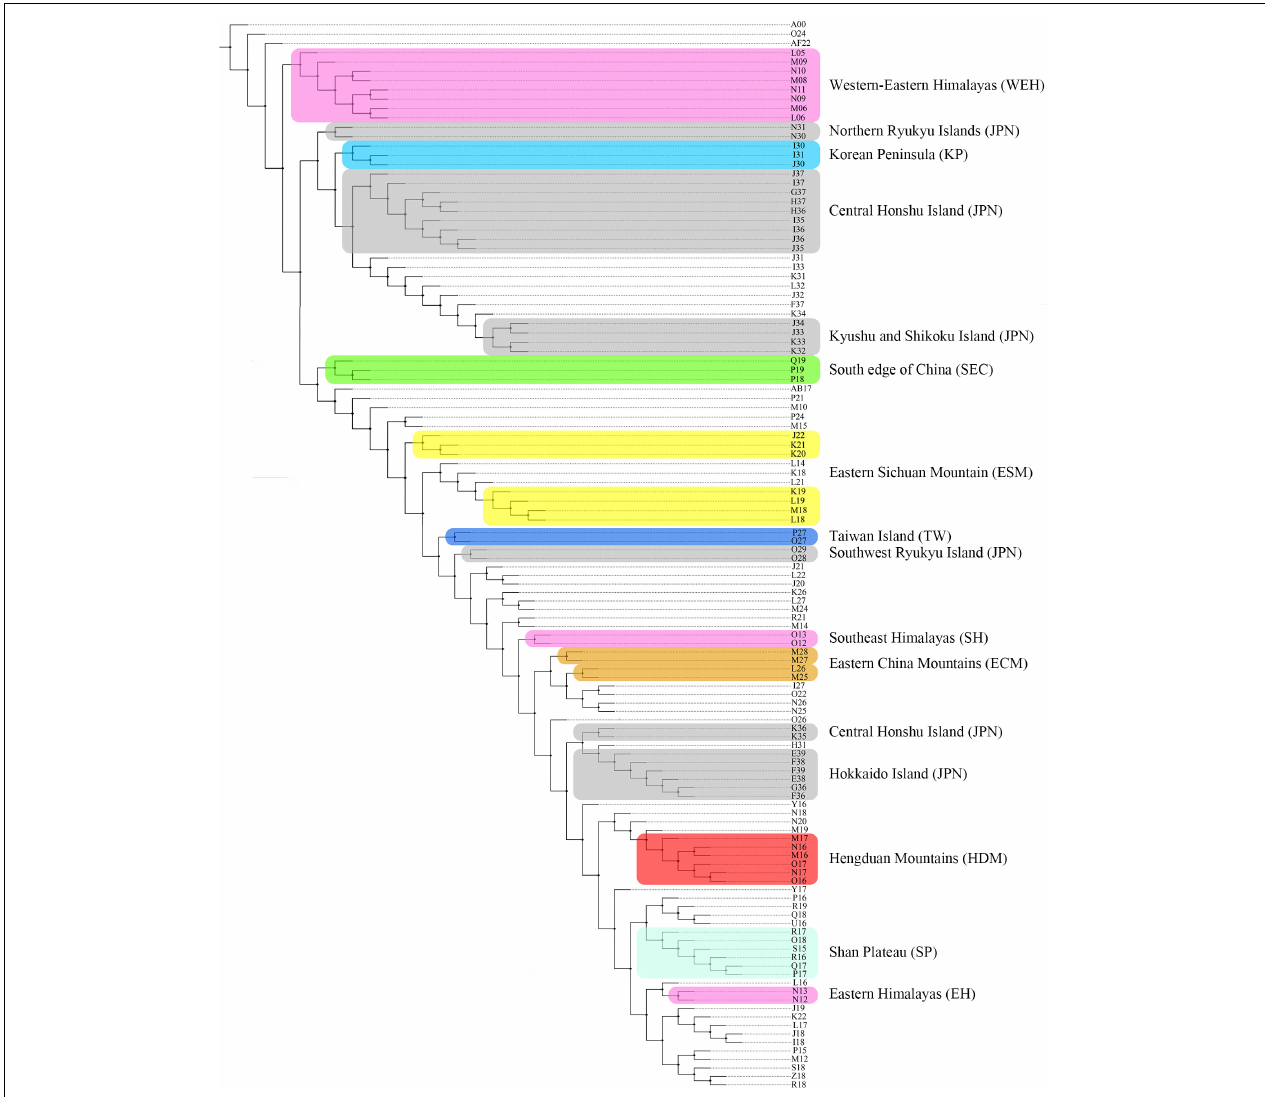
FIGURE 4 | The optimal tree obtained by PAE using TNT v1.1 under 2 ◦ grid size. Different colored shadows represent different